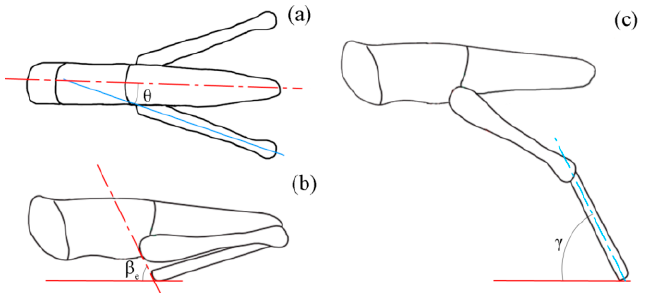
Figure 3. Schematic diagram for three postural features of adult locusts while jumping. ( a ) The opening angle between the hind femur and central line of the body just before tibial extension ( θ ); ( b ) the tilt angle of the line through the proximal femur and distal tibia just before tibial extension ( β e ); and ( c ) the tibial angle relative to the ground at take-off ( γ ).